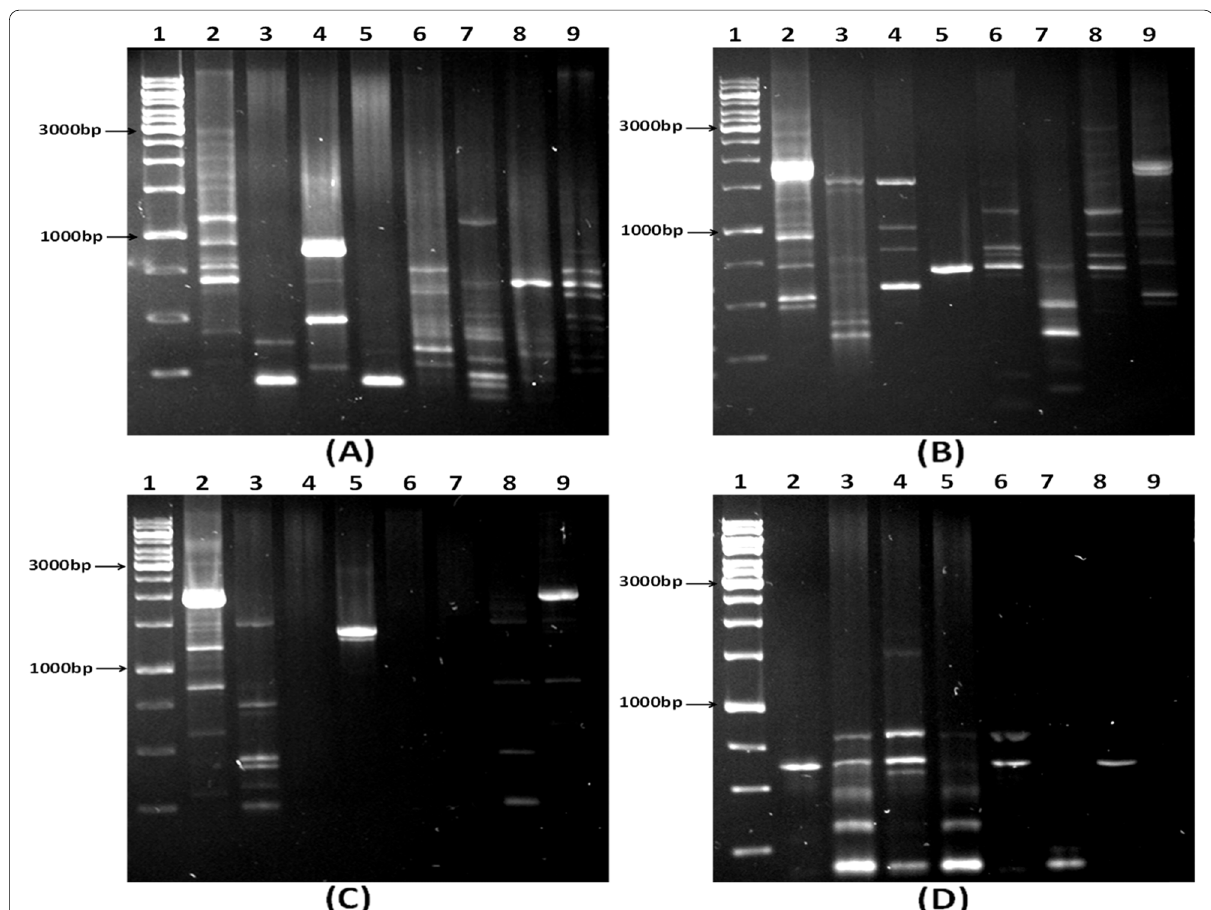
Fig. 9 Detection of genetic variation between JB140 WT and evolved mutants using RAPD primer 1 ( A ), RAPD primer 2 ( B ), RAPD primer 3 ( C ), and RAPD primers 1,2,3 ( D ). Lanes 1-1 kb DNA ladder, 2-JB140 WT , 3-JB140 Pv , 4-JB140 St , 5-JB140 Sa , 6-JB140 Sa,St , 7-JB140 Sa,Pv , 8-JB140 St,Pv , and 9-JB140